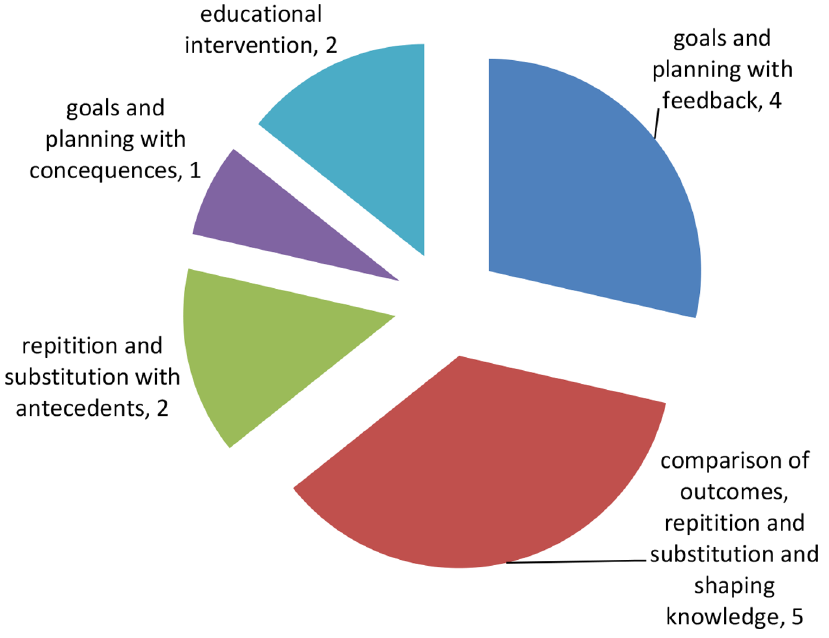
Figure 2. Breakdown of BCT combinations in physical activity interventions (n=14). The pie chart depicts the number of studies which employ specific BCT